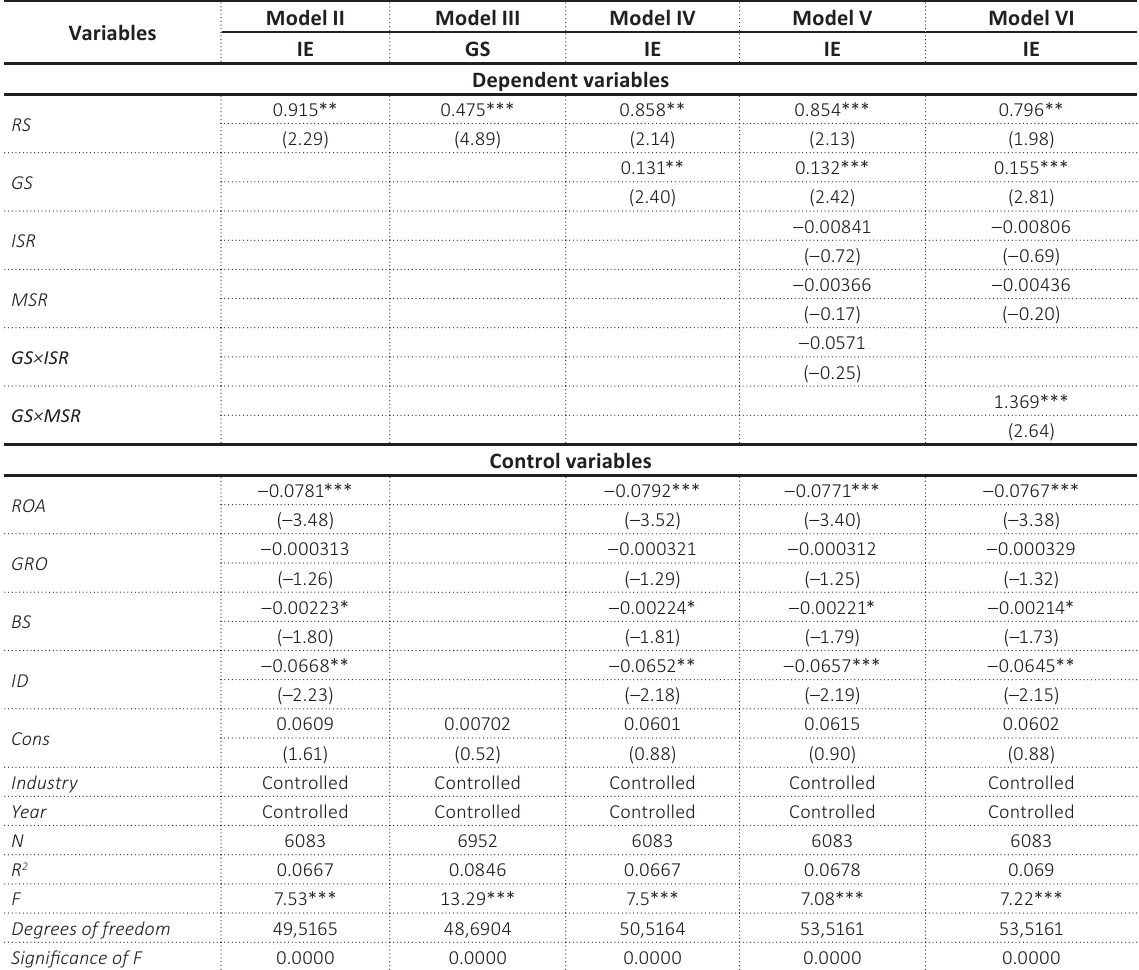
Table 5. Regression results for Model II to Model